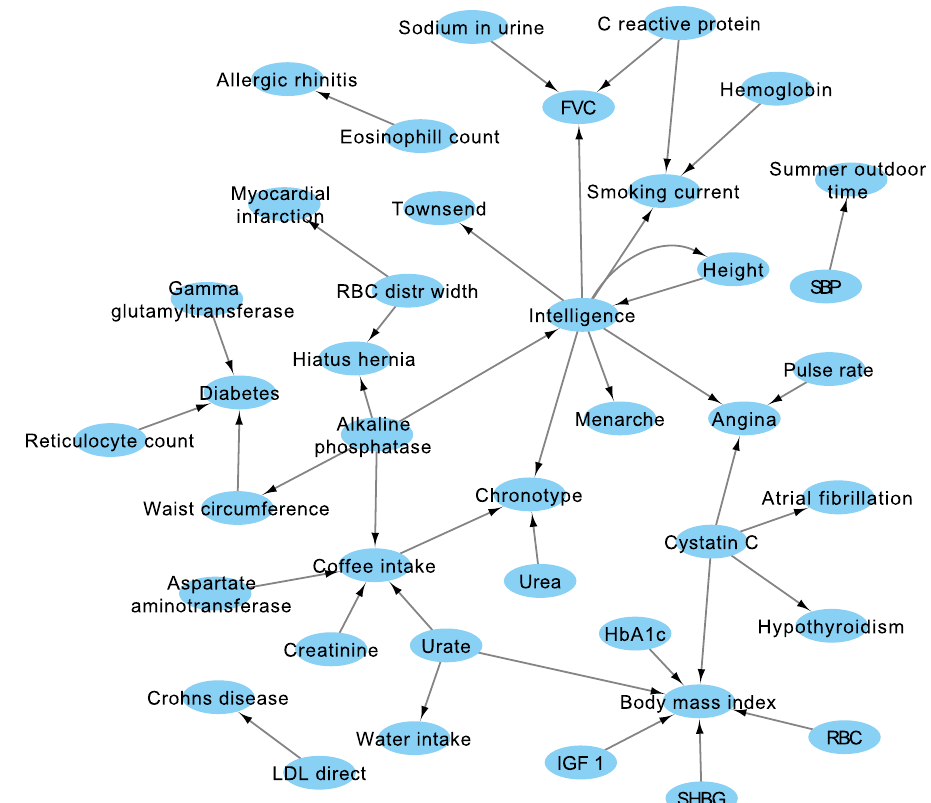
Fig. 6 The top 40 links discovered uniquely by the ExSep MS test. The null hypothesis is that there are no ExSep events. That is, that there are no genetic variants that become independent of the outcome when adjusted for the exposure. An arrow represents an ordered pair with evidence for causal interaction with a signi fi cant MS test p -value even at 1% FDR adjustment. The MS-test does not report the direction of the causal effect, but can be signi fi cant even if the causal interaction is not linear. All links in the fi gure were not discovered by the MR analysis at 10% FDR adjustment, and are thus not in Fig. 5. SBP systolic blood pressure, HbA1c hemoglobin A1c levels, FVC forced vital capacity, IGF1 insulin like growth factor 1 levels, LDL direct low-density lipoprotein levels, RBC red blood count, SHBG sex hormone-binding globulin